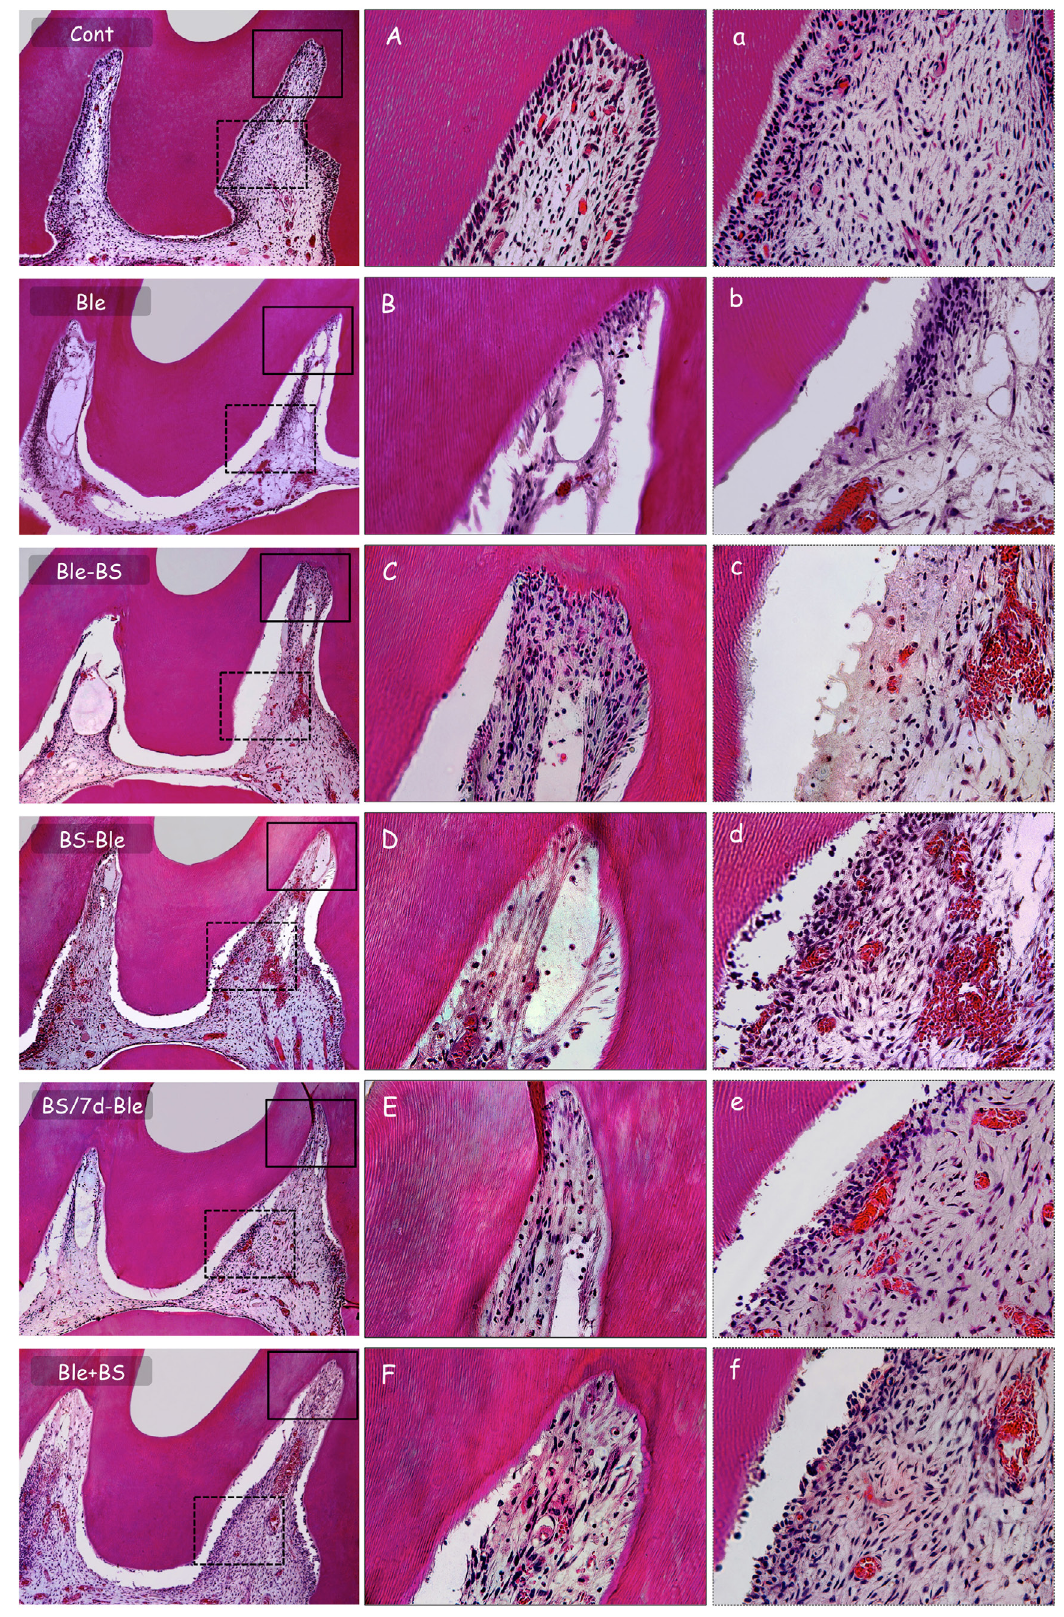
Figure 1- Representative images of the groups at 2 days. Control: panoramic microscopic aspect evidencing normal pulp tissue; (A) pulp horn region and (a) middle third of the coronary pulp with organized pulp tissue. Ble: panoramic microscopic aspect showing disorganization of pulp tissue and severe alterations; (B) pulp horn region with area of necrosis and (b) middle third of the coronary pulp with absence of odontoblastic layer and severe inflammatory infiltrate. Ble-BS: presence of pulp tissue disorganization and severe inflammatory infiltrate; (C) pulp horn and (c) middle third of the coronal pulp tissue with severe disorganization. BS-Ble; BS/7d-Ble; Ble+BS: presence of moderate inflammatory infiltrate in partial tissue disorganization; (D, E, F) pulp horn and (d, e, f) middle third of the coronal pulp with higher tissue organization and presence of inflammatory cell. [100X, 400X;